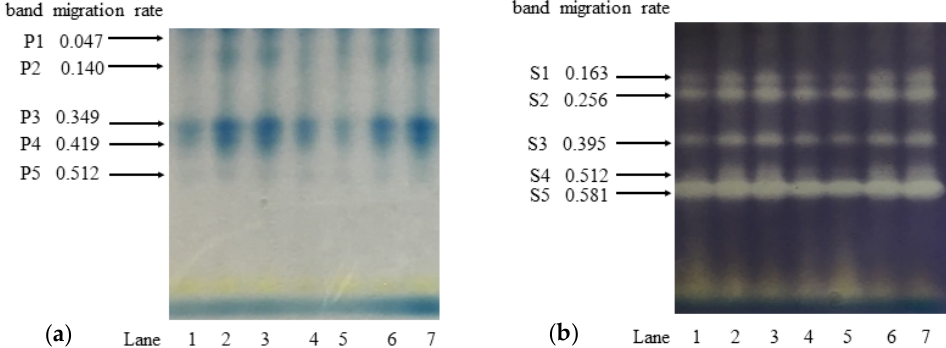
Figure 6. Activity of ( a ) peroxidase (POD) and ( b ) superoxide dismutase (SOD) isozyme in leaves of maize as affected by